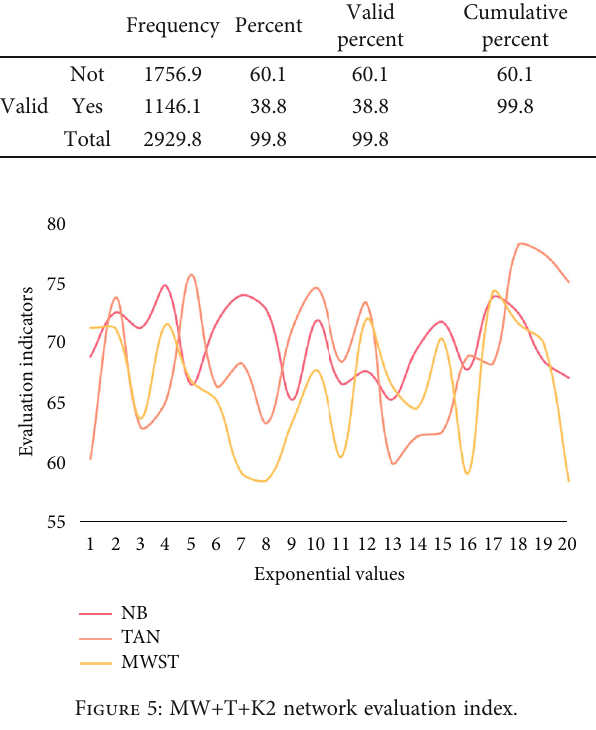
Figure 5: MW+T+K2 network evaluation index.